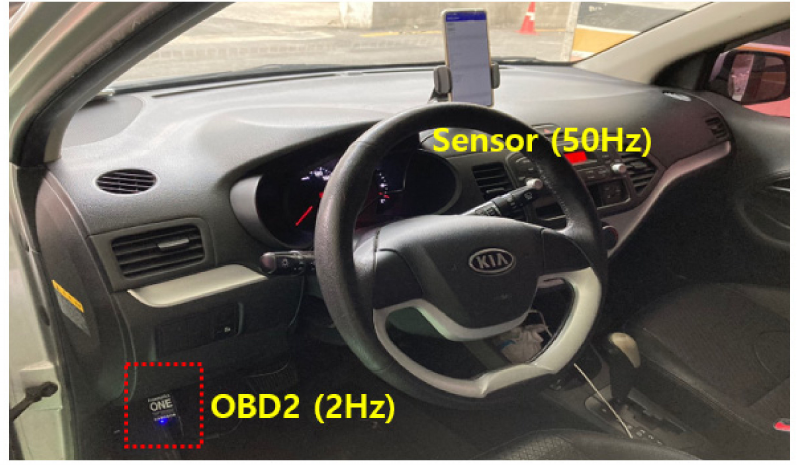
Figure 10. Experimental setup.